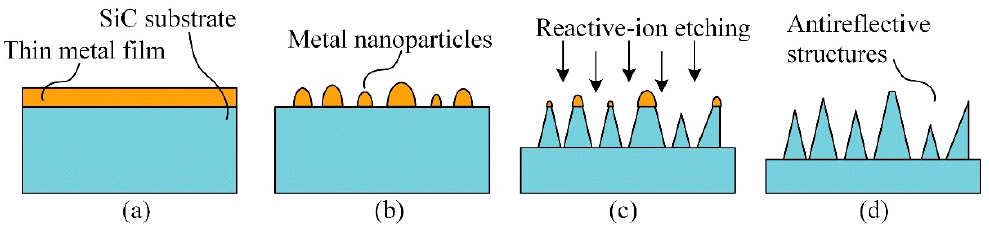
Figure 1. Schematic illustrations of the sub-wavelength antireflective structure fabrication steps: ( a ) Thin metal film deposition; ( b ) Rapid thermal process to form the nanopatterns; ( c ) Dry etching process; ( d ) Removal of residual mask.